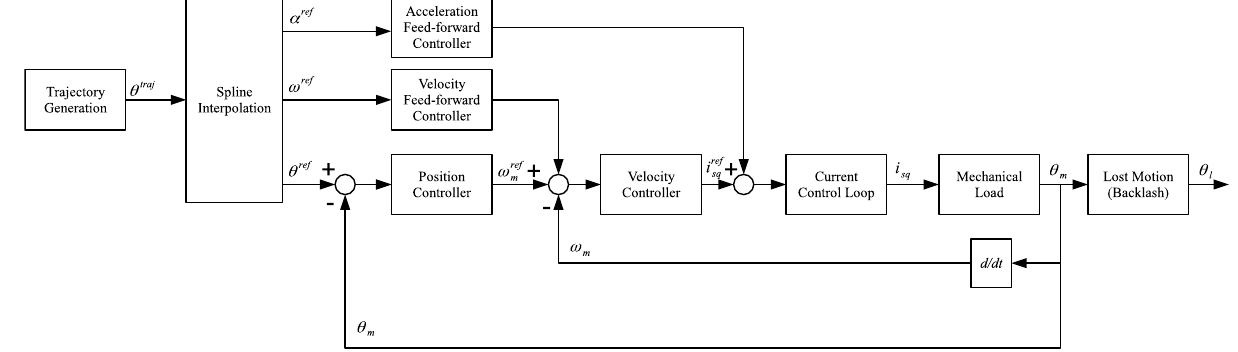
Figure 1. Block diagram of a common servo control system in the CNC machine